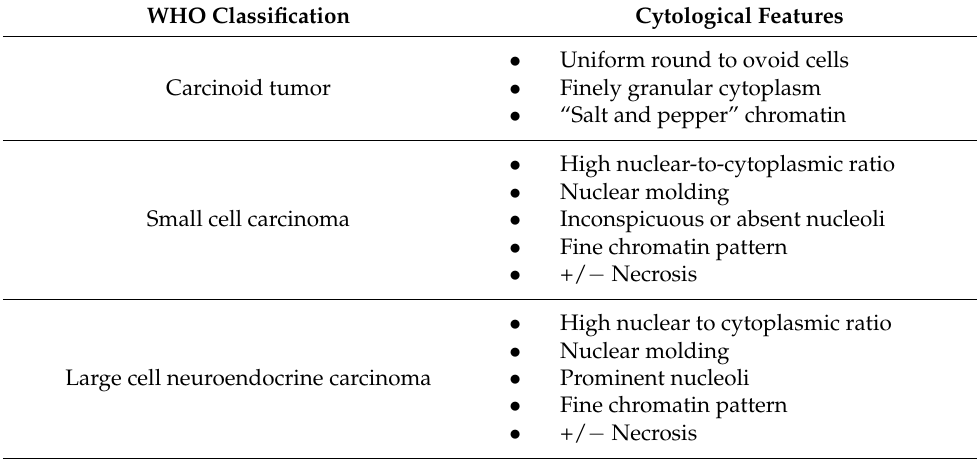
Table 3. Cytological features of thymic neuroendocrine